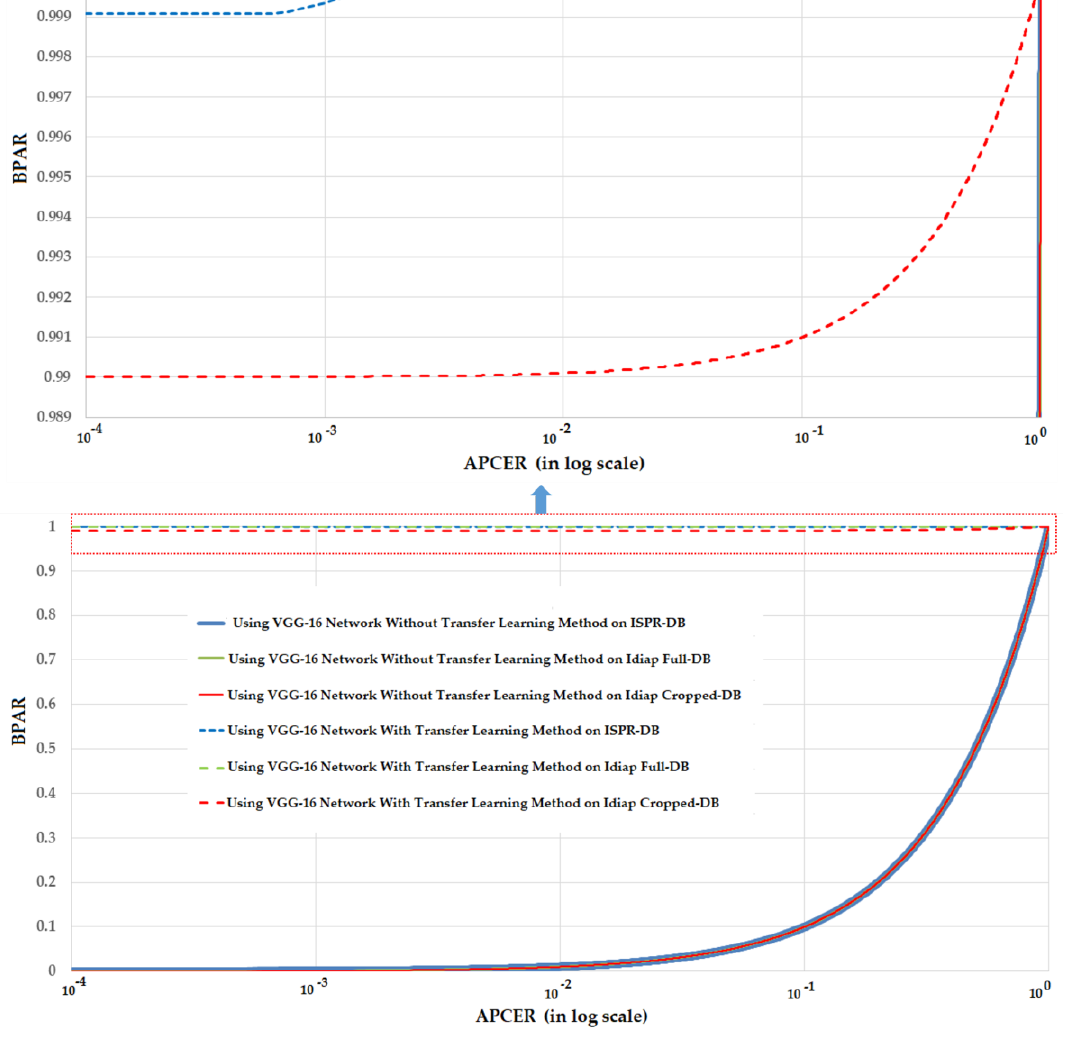
Figure 8. The DET curves of PAD method (in log scale) based on VGG-16 network with three different databases: ISPR-DB, Idiap Full-DB and Idiap Cropped-DB database; and two training modes: with and without applying the transfer learning method.